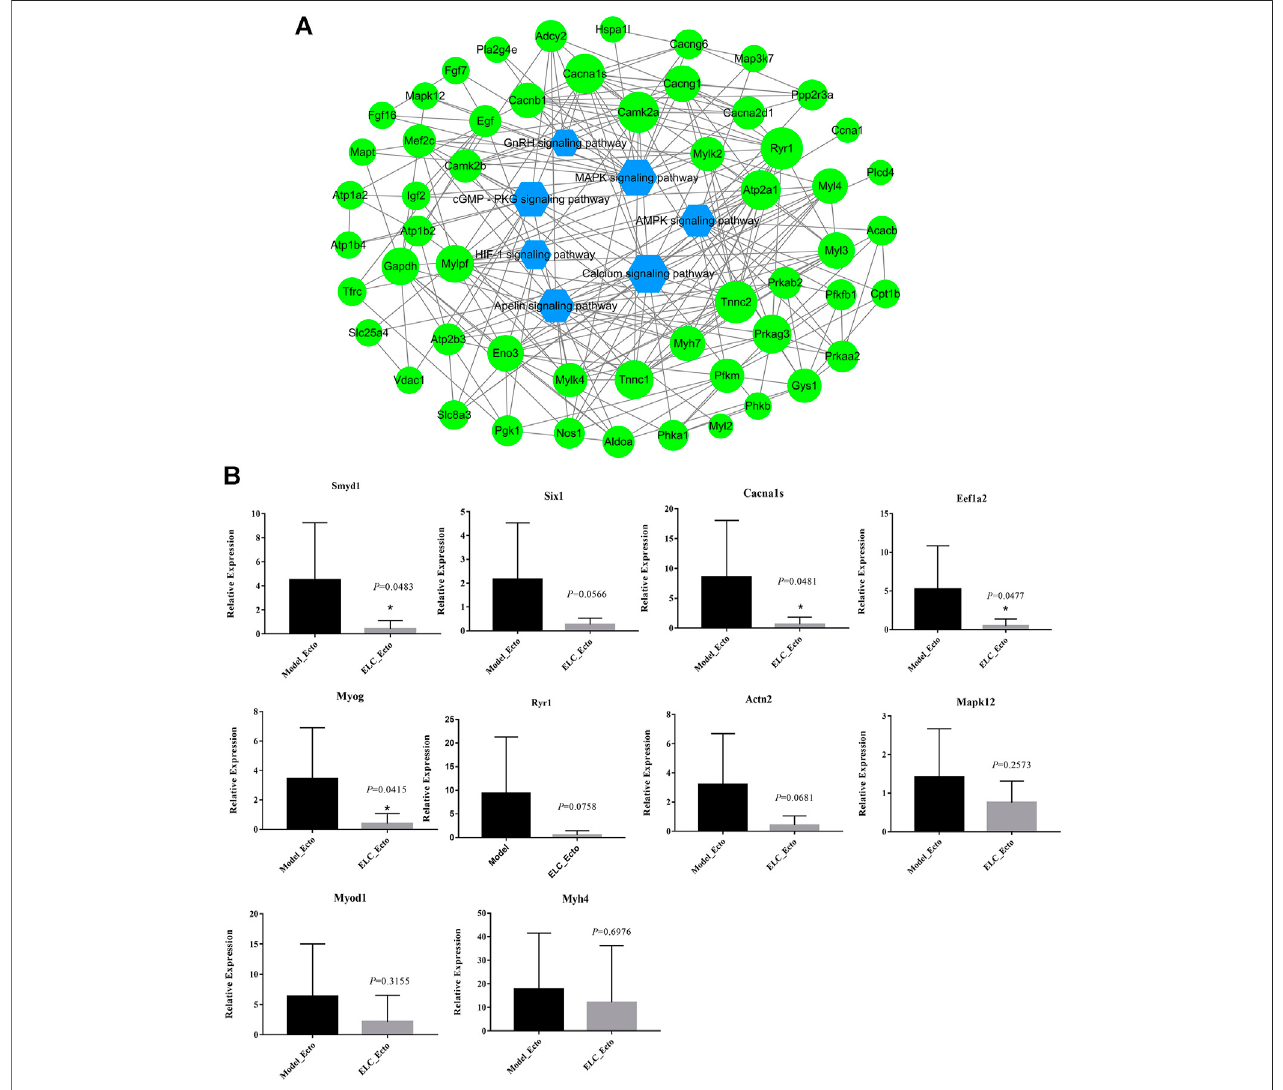
FIGURE 9 | DEG effect of ELeng Capsules in the endometriosis model rats. (A) Network of major KEGG pathways and targets of Model_Ecto vs. ELC_Ecto downregulated DEGs. (B) Expression of genes in ectopic endometrium tissues in endometriosis rat models detected by qRT-PCR and shown by the expression fold changes. ACTB was used as the internal control. Data are shown as mean ± SD, * p < 0.05.